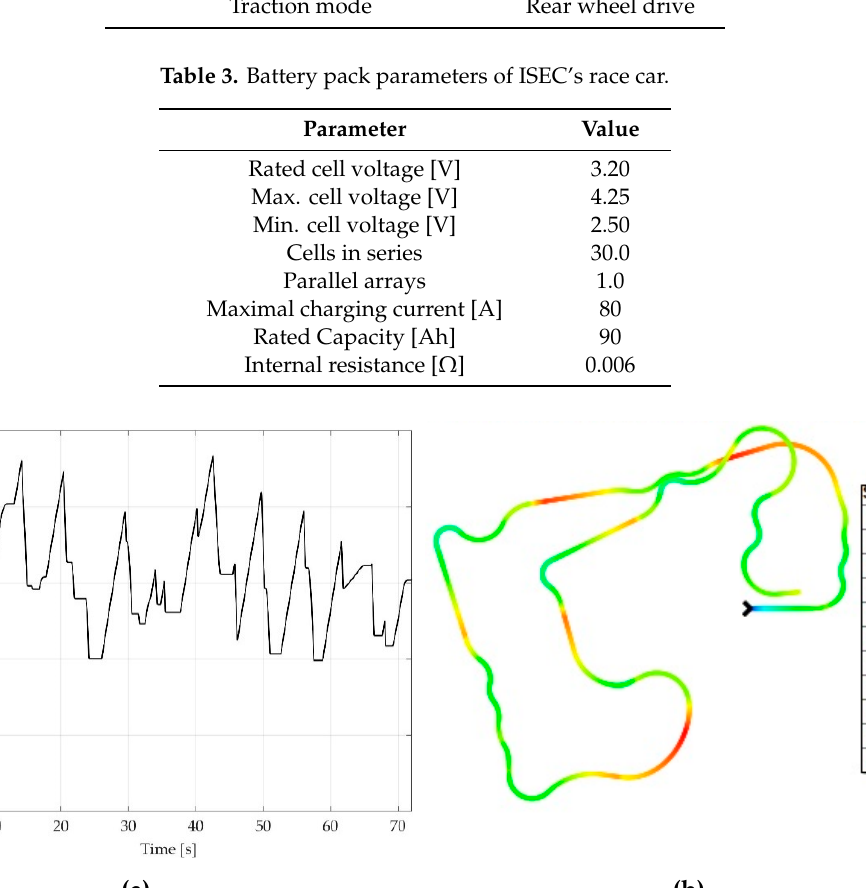
Table 3. Battery pack parameters of ISEC’s race car.